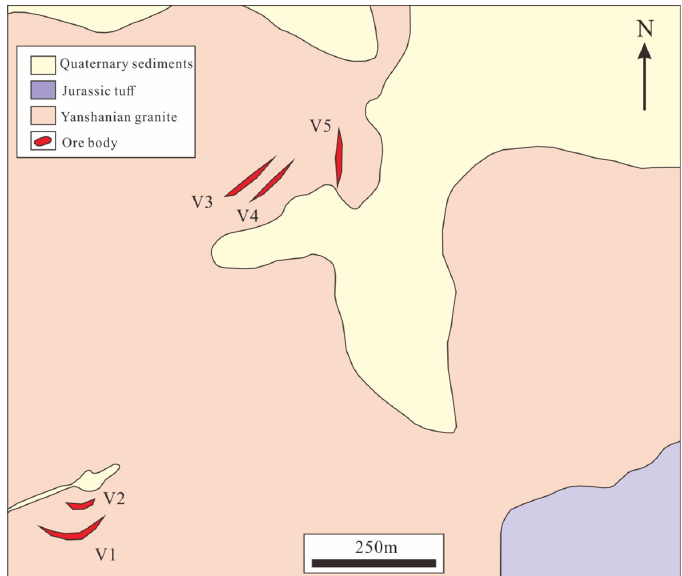
Figure 3. Geological map of the Baiyinhan tungsten deposit.